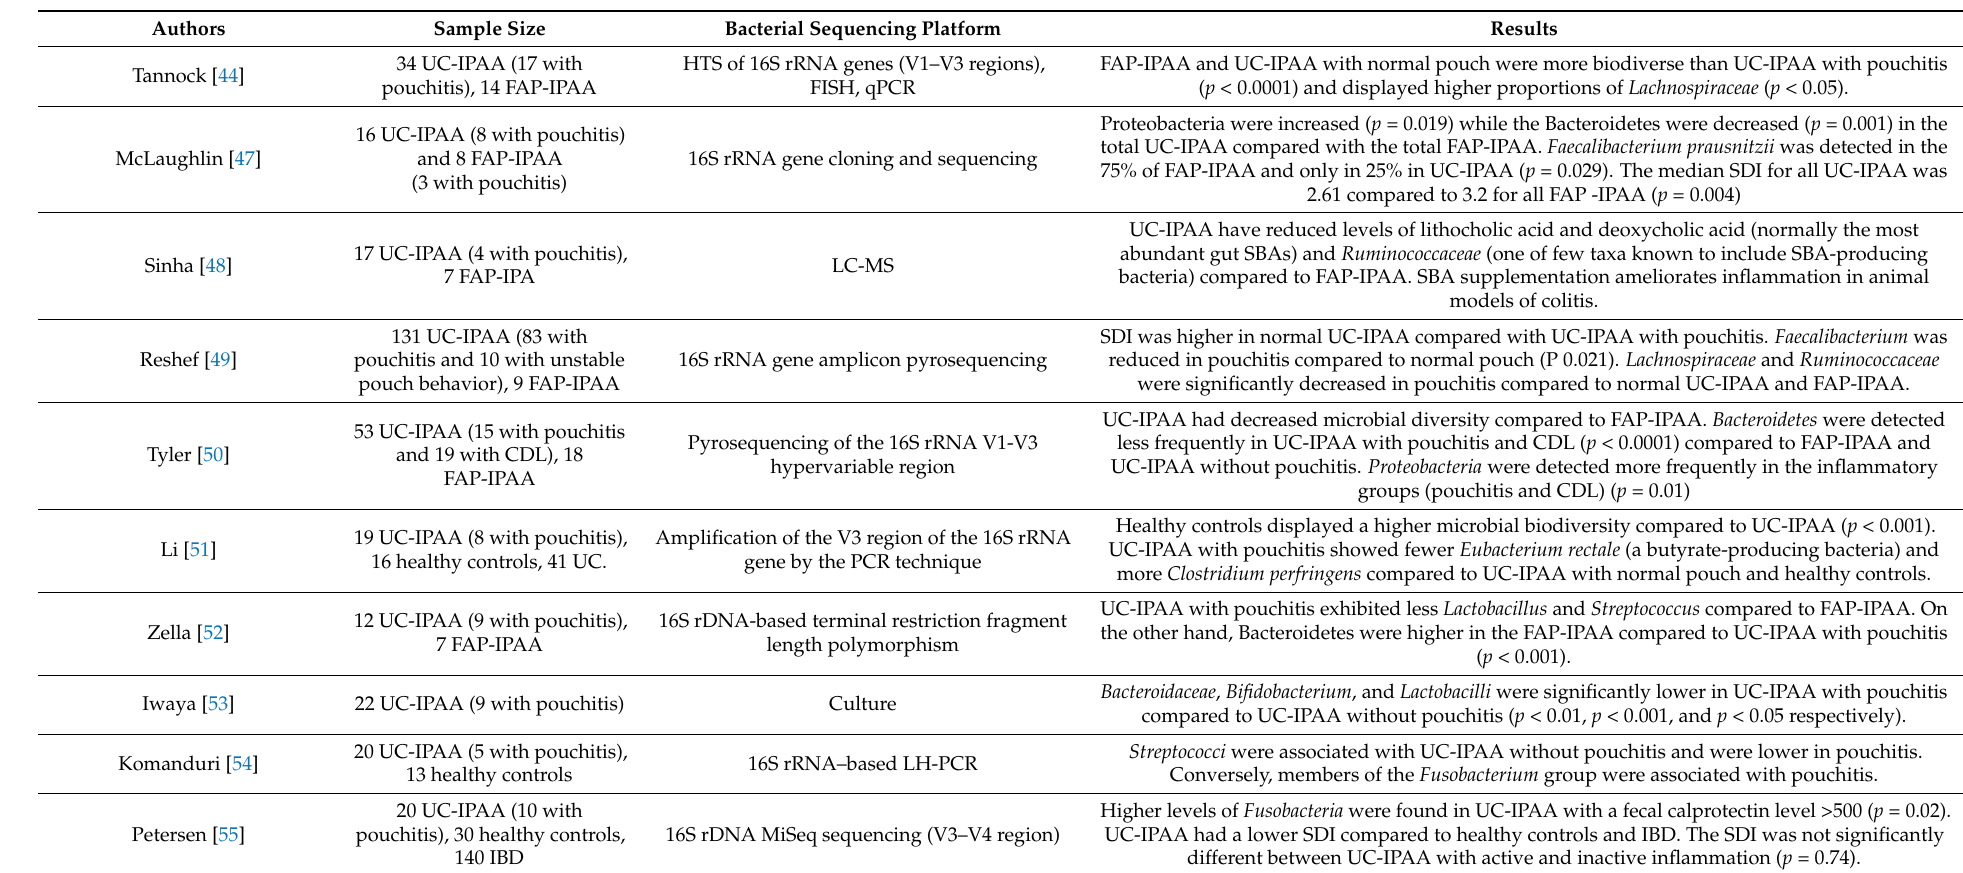
Table 2. Summary of the studies describing the alterations of the microbiota in UC-IPAA patients with